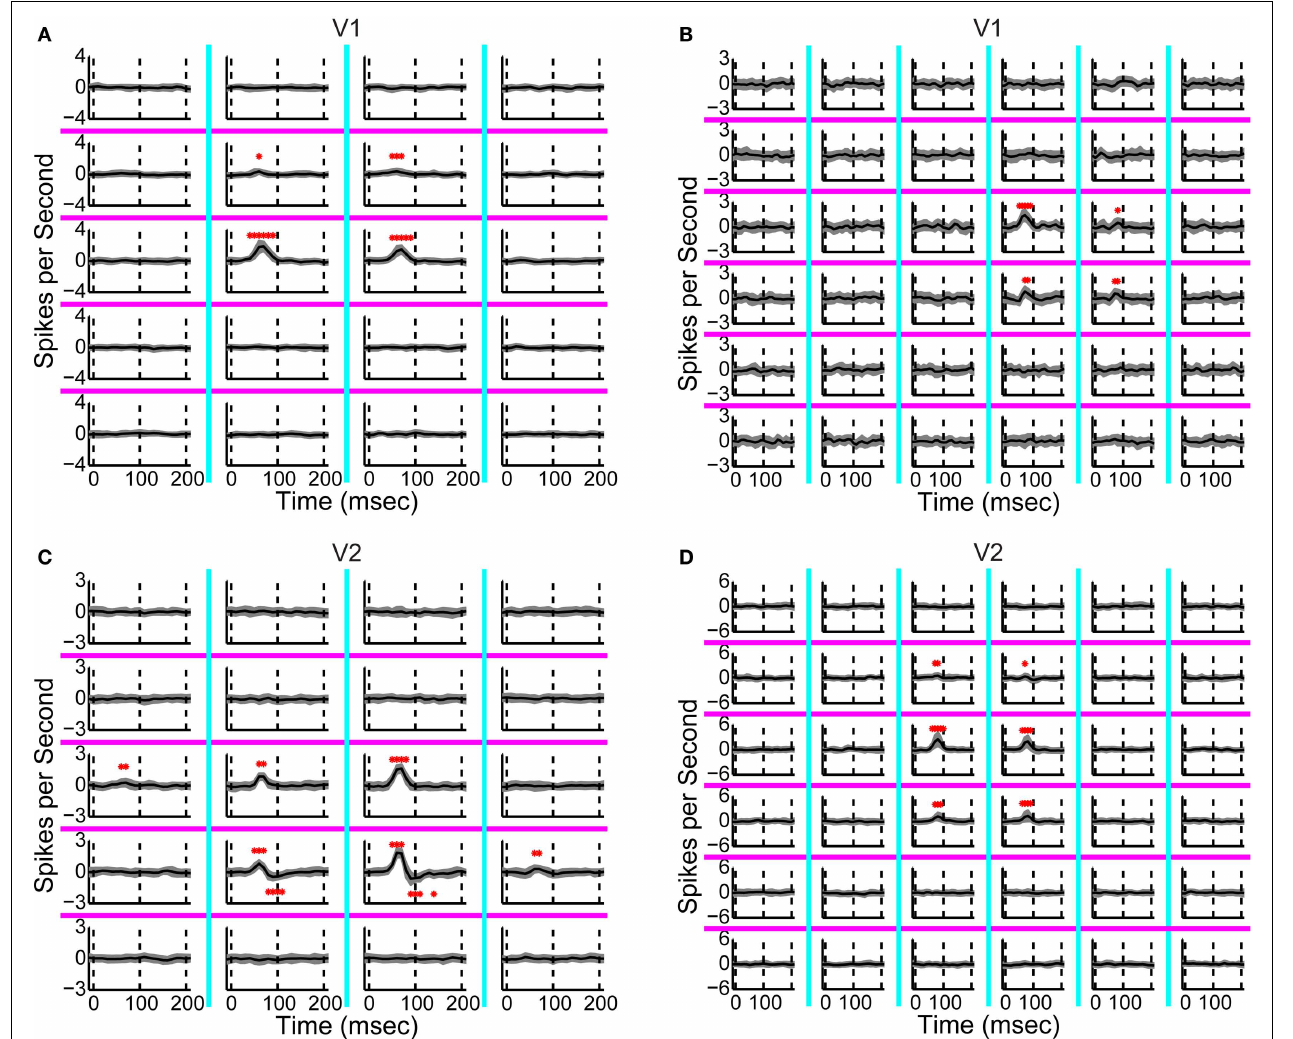
signifi cantly different from zero (two-tailed t -test, α = 0.01, corrected for multiple comparisons). Dashed vertical lines show the timepoints 0, 100 and 200 ms. (B) First-order response kernels of another V1 neuron measured using the 6 × 6 layout. The check size of the stimulus was 0.4 × 0.4 degrees of visual angle. (C) First-order response kernels of a V2 neuron. The check size of the stimulus was 0.6 × 0.75 degrees of visual angle. (D) First-order response kernels of a V2 neuron. The check size of the stimulus was 0.4 × 0.2 degrees of visual